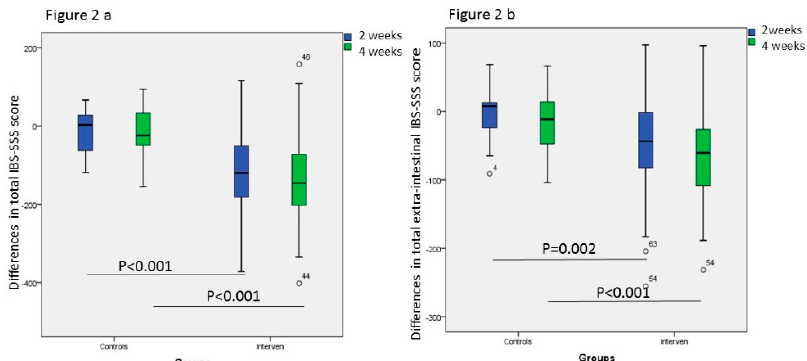
Figure 2. Comparison between the control and intervention group of the differences in ( a ) total irritable bowel syndrome–symptom severity scale (IBS-SSS) and ( b ) total extra-intestinal IBS-SSS scores between week 2 and baseline, and week 4 and baseline, after introduction of a starch- and sucrose-reduced diet. Mann-Whitney U test. P < 0.05 was considered statistically significant.